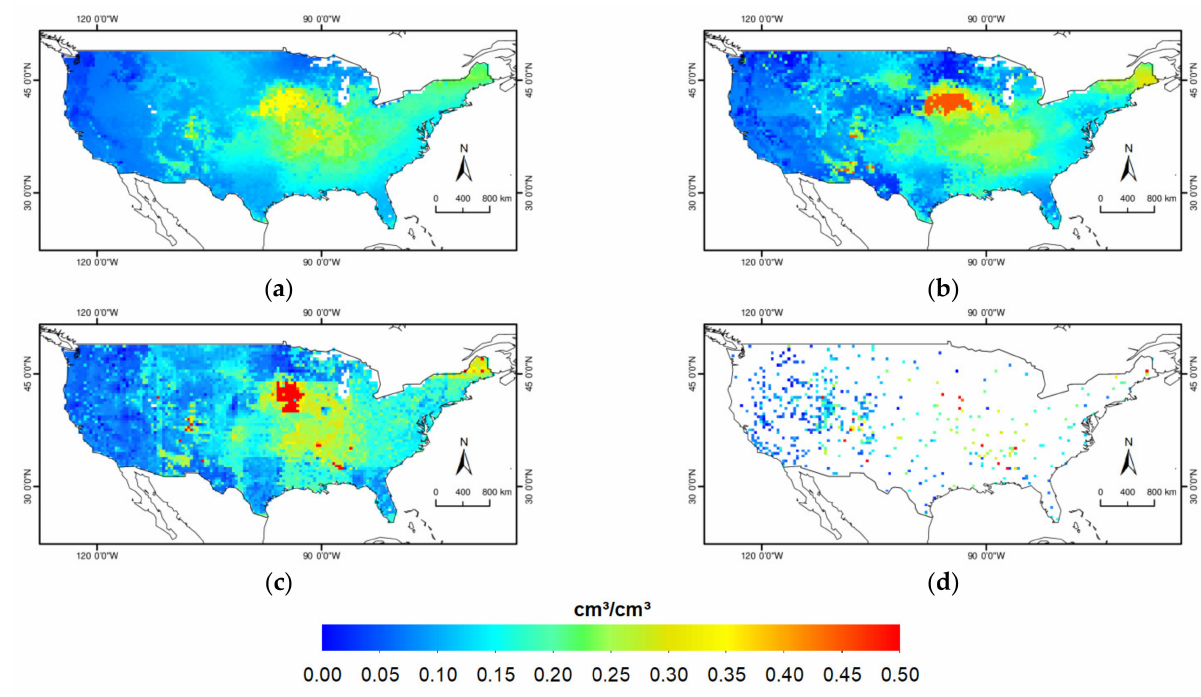
Figure 11. Mean SM maps of August 2015 obtained by different models. ( a ) BPNN, ( b ) GRNN, ( c ) Multi-MDA-RF, and ( d ) in-situ